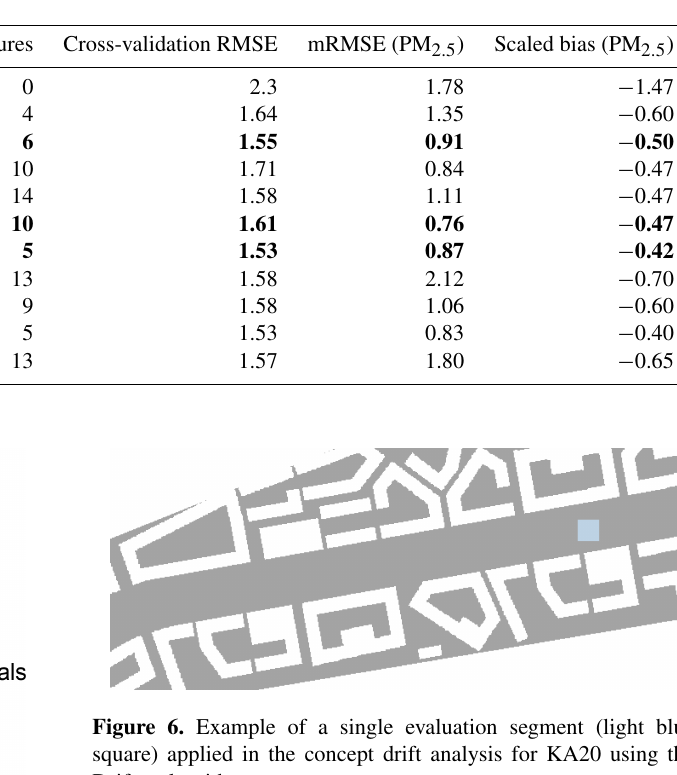
Table 4. Cross validation and evaluation error for all models, obtained with their respective optimal set of features. Cross-validation RMSE is on KU18, while mRMSE and scaled bias are calculated on PM 2 . 5 in KA20. In bold are the three models that were ultimately selected for performance (based on cross-validation RMSE) or interpretability.